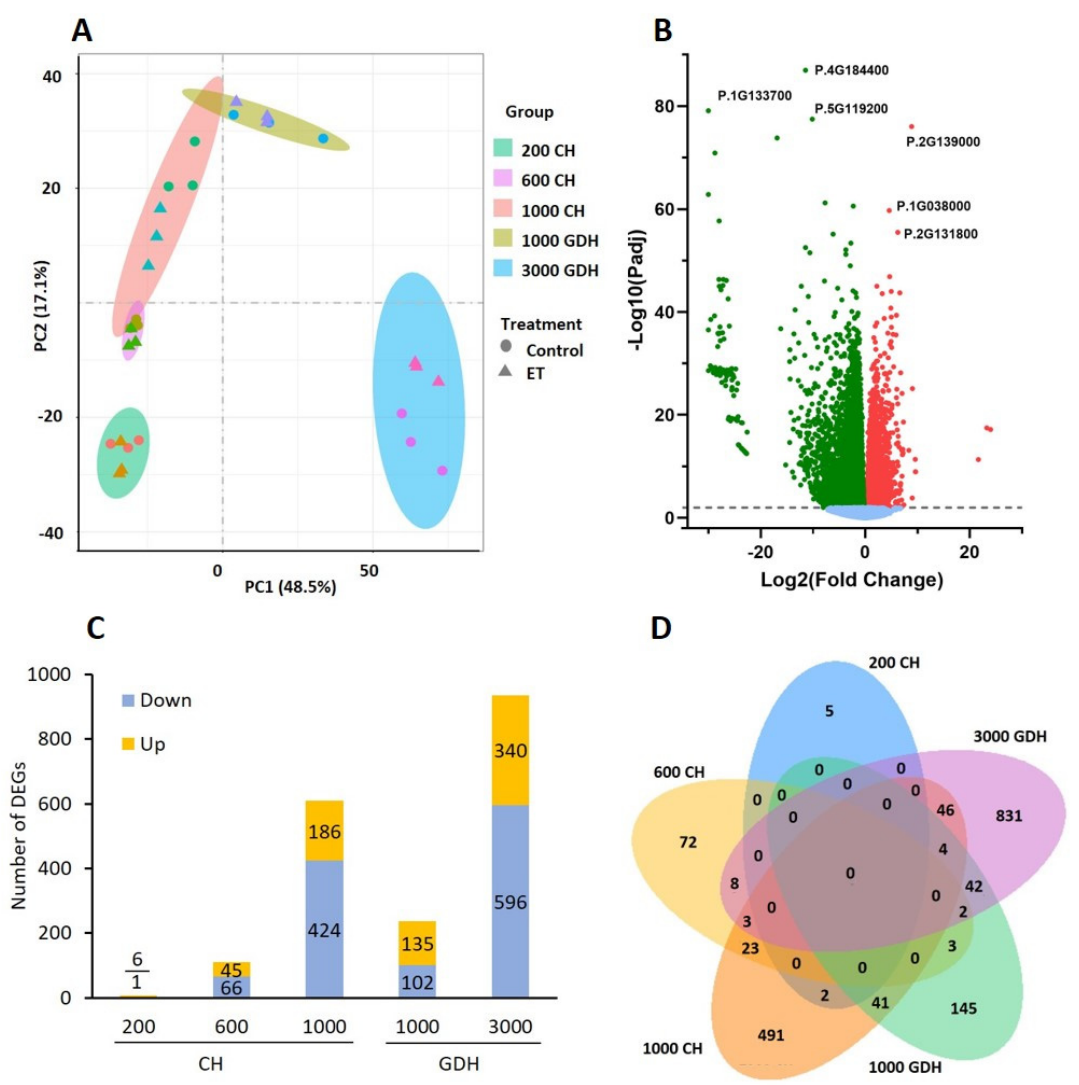
Figure 2. Transcriptome profiles of peach buds in the ET treatment and the control during endodormancy and ecodormancy. ( A ) Principal component analysis (PCA) of transcriptomic profile of the ET treatment and the control in floral buds of peach. ( B ) Volcano plot of 11,582 non − DEGs (light blue) and 15,053 DEGs (ecodormancy vs. endodormancy), with 7089 upregulated (red) and 7964 downregulated (green). ( C ) The numbers of DEGs (|Log2 fold change| > 1, FDR < 0.05) arising from the ET treatment at five sampling times (CH: chilling hour; GDH, growth-degree hour). ( D ) Venn diagram of DEG distribution at each sampling time. A hierarchical clustering analysis on all the samples produced five well-separated groups corresponding to the sampling time (Figure 3). The expression patterns in groups of endodormancy (200, 600, and 1000 CH) were in sharp contrast to those in ecodormancy (1000 and 3000 GDH), in which the genes that were upregulated during endodormancy became downregulated during ecodormancy, and vice versa. The difference in expression patterns between the ET treatment and the control increased over time, and the most distinct patterns were found in the 3000 GDH